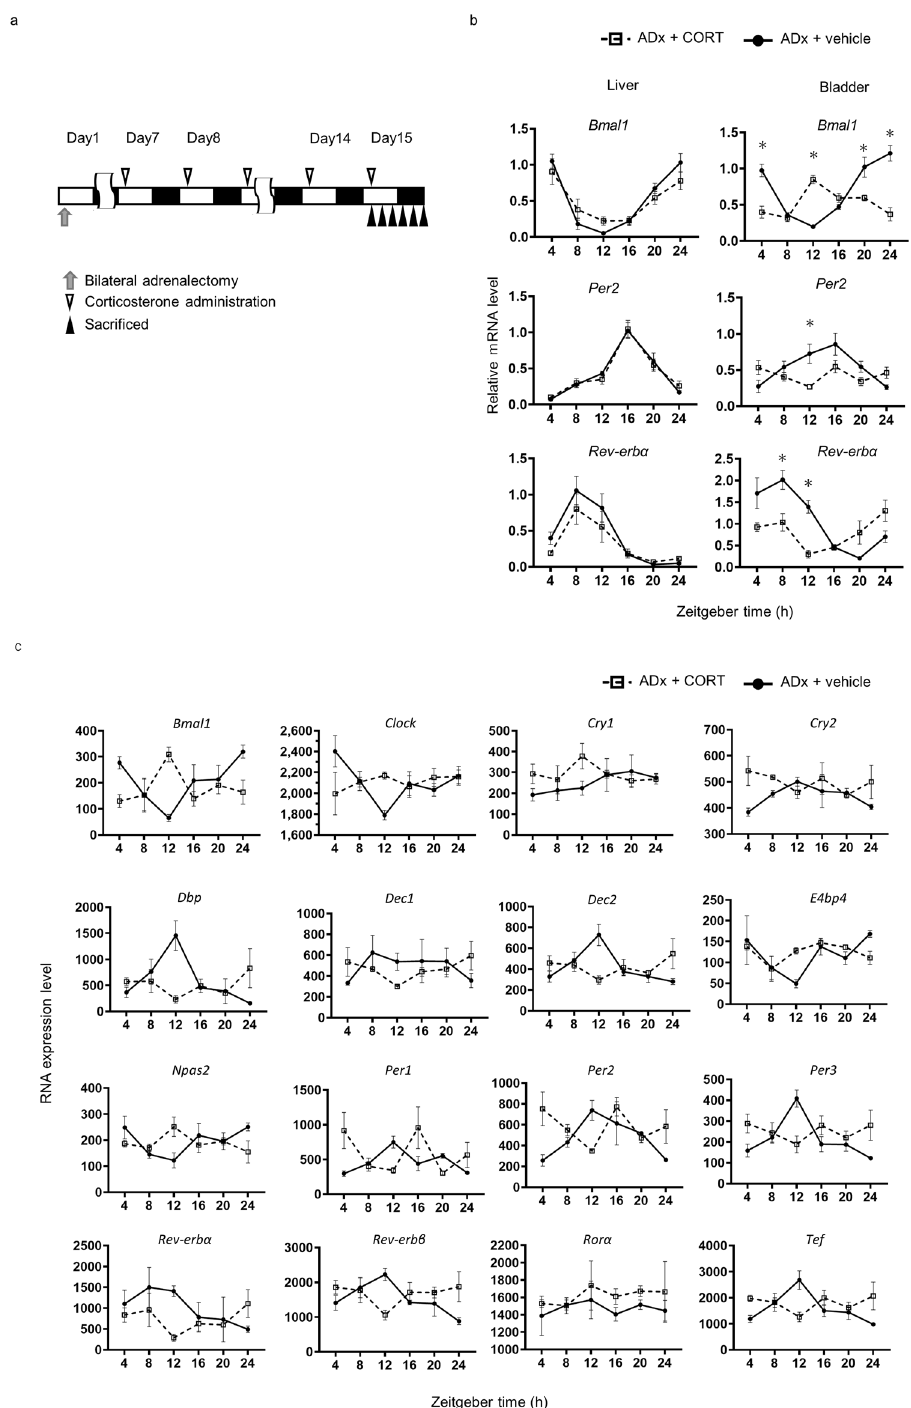
Fig. 5 Effect of bilateral adrenalectomy and corticosterone administration at the non-physiological timing. a A schematic diagram of the bilateral adrenalectomy (ADx) performed on Day 1 and corticosterone administered orally for 7 days at ZT 1 from Day 8 after ADx and sacri fi ce on Day 15 (ADx + CORT). b Relative mRNA accumulation of Bmal1 , Per2, and Rev-erb α in the liver and bladder from ADx + vehicle (solid line) and ADx + CORT (dash line). Each data series represents the mean ± SEM and 5 mice per time point. Differences were determined by two-way ANOVA and Sidak ’ s multiple comparisons test. * p < 0.01 v.s. ADx + vehicle. c Temporal mRNA accumulation of clock genes in the bladder from ADx + vehicle (solid line) and ADx + CORT (dash line) by analyzing RNA-seq. Each data series represents the 3 mice per time